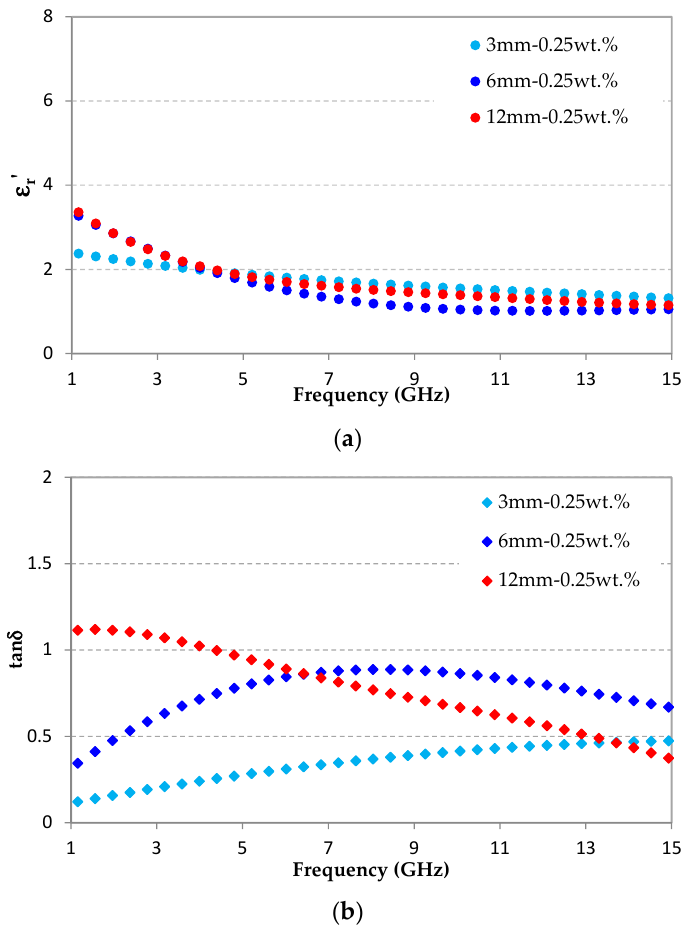
Figure 9. Dielectric properties of epoxy foams loaded with 0.25 wt.% of 3, 6, and 12 mm-CFs: ( a ) real part of the relative permittivity and ( b ) dielectric losses.